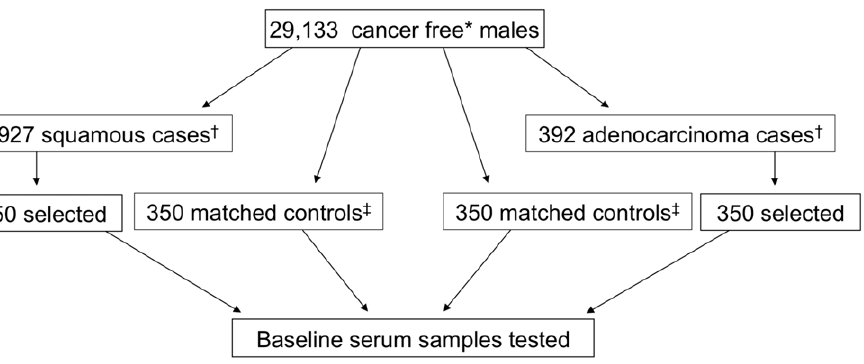
Figure 1. Lung cancer case and control selection for Helicobacterpylori serology testing within the ATBC cohort. *Individuals with nonmelanoma skin cancer were not excluded. { Eligible cases included all first primary lung squamous cell carcinoma or adenocarcinoma cases diagnosed at least 1 year after the baseline draw date through 30 July 2007. { Controls were matched one-to-one by age at baseline serum draw ( + / 2 5 years) and date of baseline serum draw ( + / 2 30 days). Controls had to be alive and cancer free at the date that the corresponding case was diagnosed.